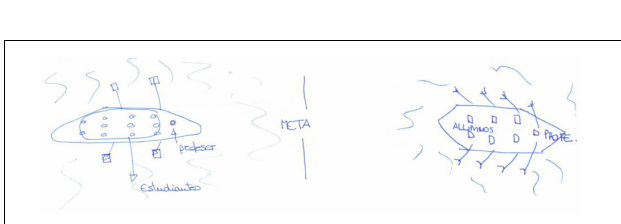
FIGURE 4 | E27’s drawings of a class as rowing crew in the pre-test and in the post-test.